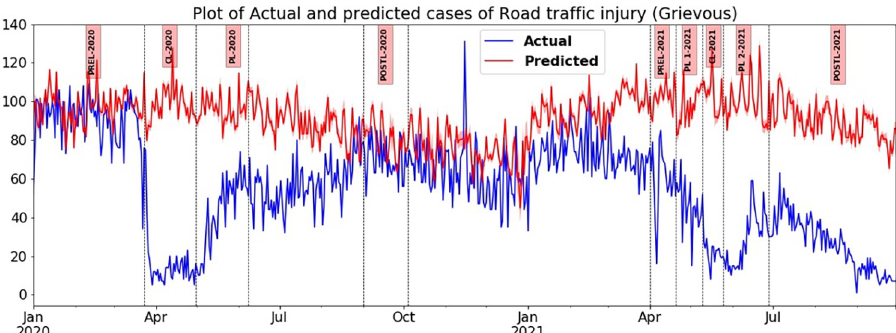
Fig 5. Plot of the daily number of grievous Road Traffic Injuries (RTI-Grievous) in TN actual versus predicted during various phases of wave one and wave two in 2020 and 2021.